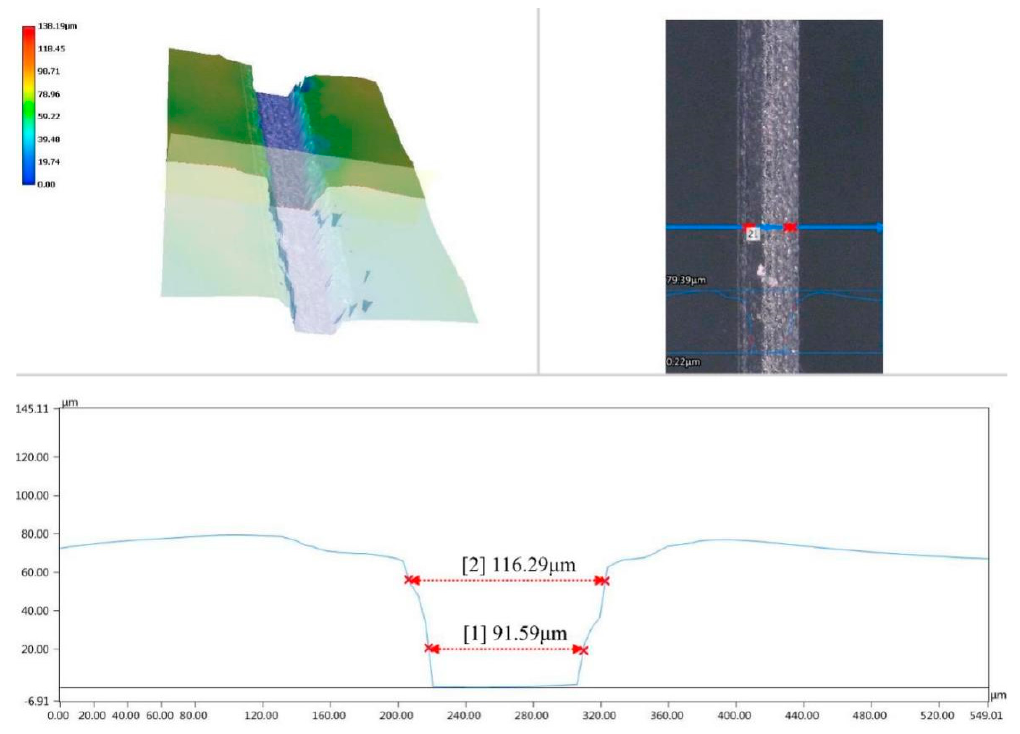
Figure 7. Observation results of single groove PMMA specimen (power: 3 W and scanning speed: 1.0 mm/s) under ultra-depth microscope.